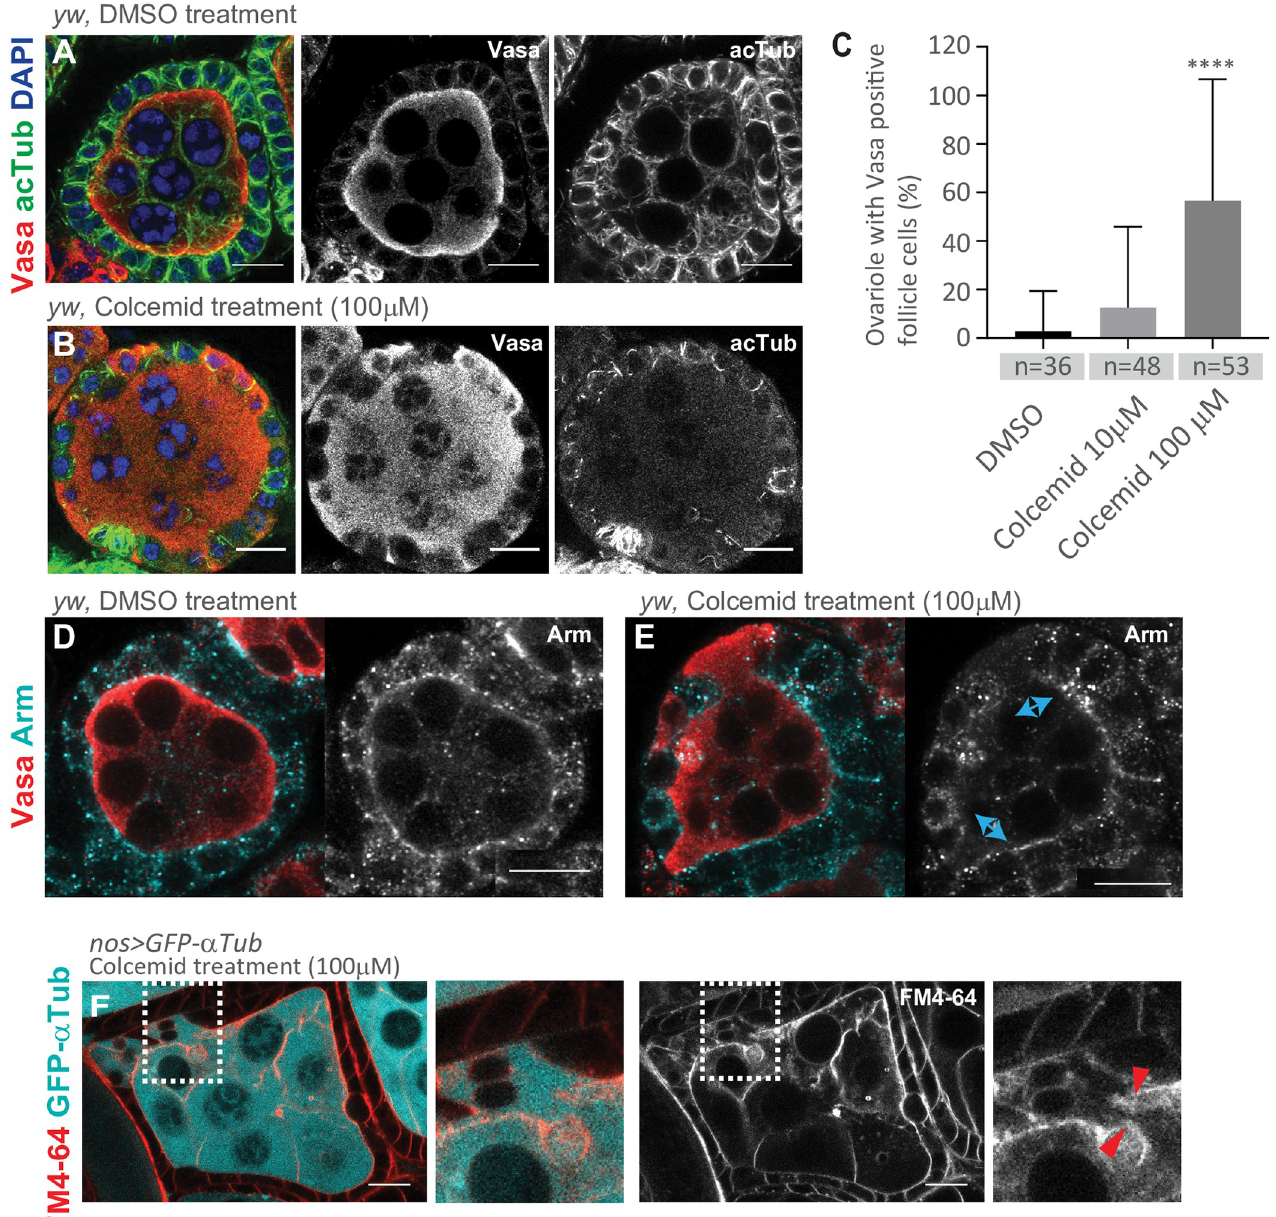
Fig 4. Short-term Colcemid treatment recapitulates Vasa mislocalization observed in lky KO ovaries. A, B ) Representative images of stage 3–4 egg chambers incubated with DMSO ( A ) or 100 μ M Colcemid ( B ) for 30 min after dissection. IF staining was performed for Vasa and acTub. C ) A graph shows frequency of ovarioles with any Vasa-positive FCs after indicated treatments. D, E ) Representative images of IF staining for Vasa and Arm in ovaries after incubated with DMSO (control, D ) or Colcemid ( E ). Blue arrows in E indicate germ cell/FC boundary with disrupted junctions visualized by Arm staining. F ) A representative image of a live egg chamber (stage 3–4) with visualized its plasma membrane by FM4-64 dye after Colcemid treatment. Germline-expressed GFP- α Tub shows leakage into FCs through ruptured plasma membrane. Right panels show magnified portion of missing membrane (squared in left panels). For C , adjusted P values from Dunnett’s multiple comparisons test is shown, and a minimum of 20 ovaries were used from two individual experiments. Scale Bars: 10 μ